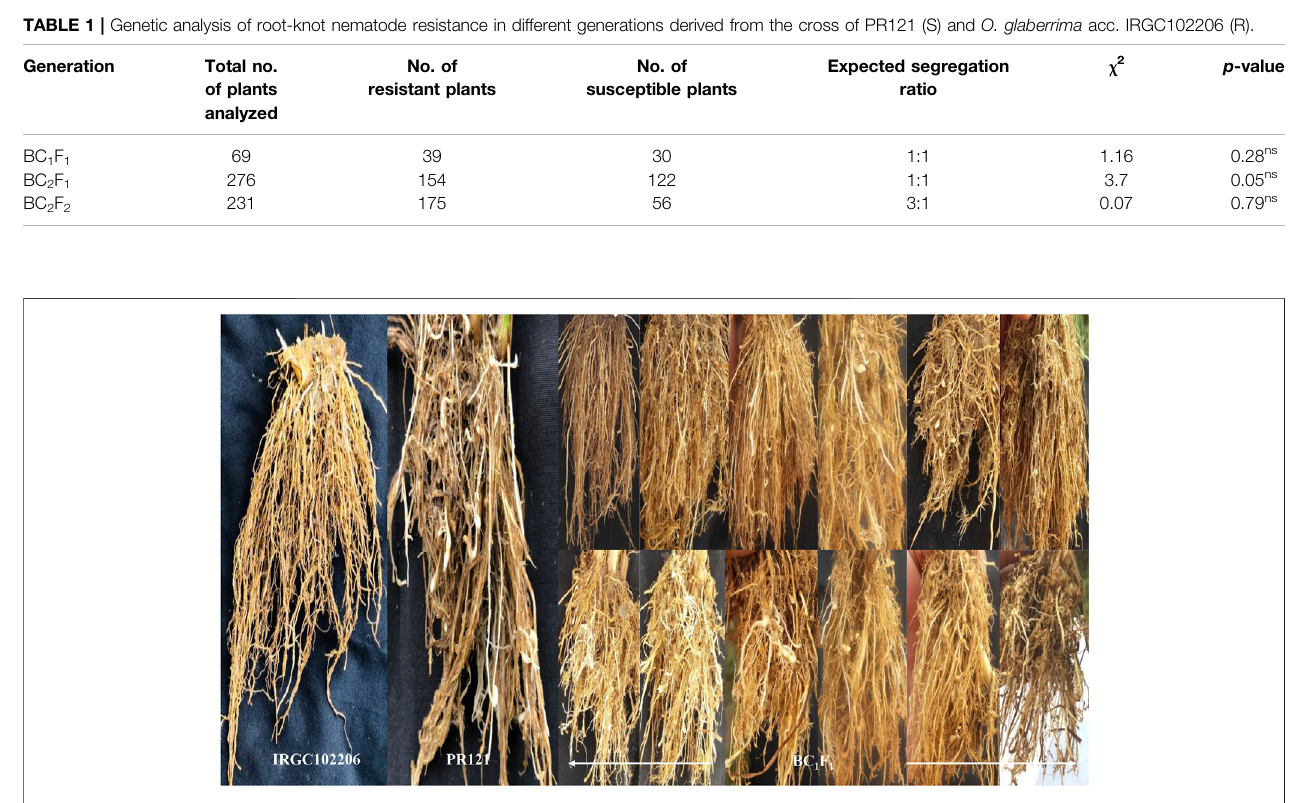
FIGURE 2 | Response of O. glaberrima acc. IRGC102206 (R), PR121 (S), and their derived BC 1 F 1 progenies upon M. graminicola infestation.